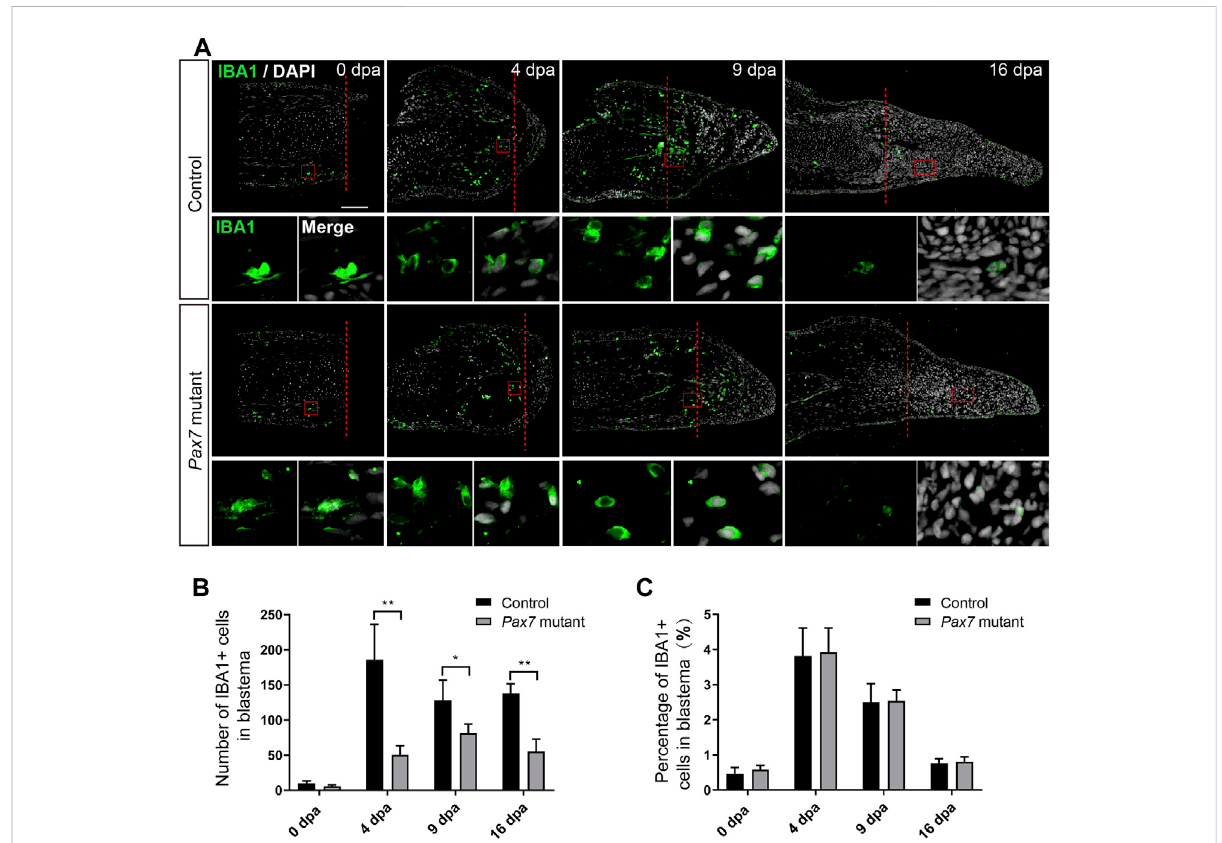
FIGURE 2 Macrophage dynamics in limb regeneration of Pax7 mutants. (A) Immuno fl uorescence images of IBA1 (green) and DAPI (white) in limb longitudinal-sections, at 0, 4, 9 and 16 dpa, from control and Pax7 mutant animals. Boxed regions are shown at higher magni fi cation as separated channels. Red dashed lines, amputation planes. Scale bars, 200 μ m. (B) and (C) Quanti fi cation of the absolute number (B) and the percentage (C) of IBA1 positive cells, within the areas of the newly formed blastema combined 500 μ m zone proximal to the amputation plane, at 0, 4, 9 and 16 dpa, from controls ( n = 4) and Pax7 mutants ( n = 4). Data are presented as mean ± sem, * p < 0.05, ** p <